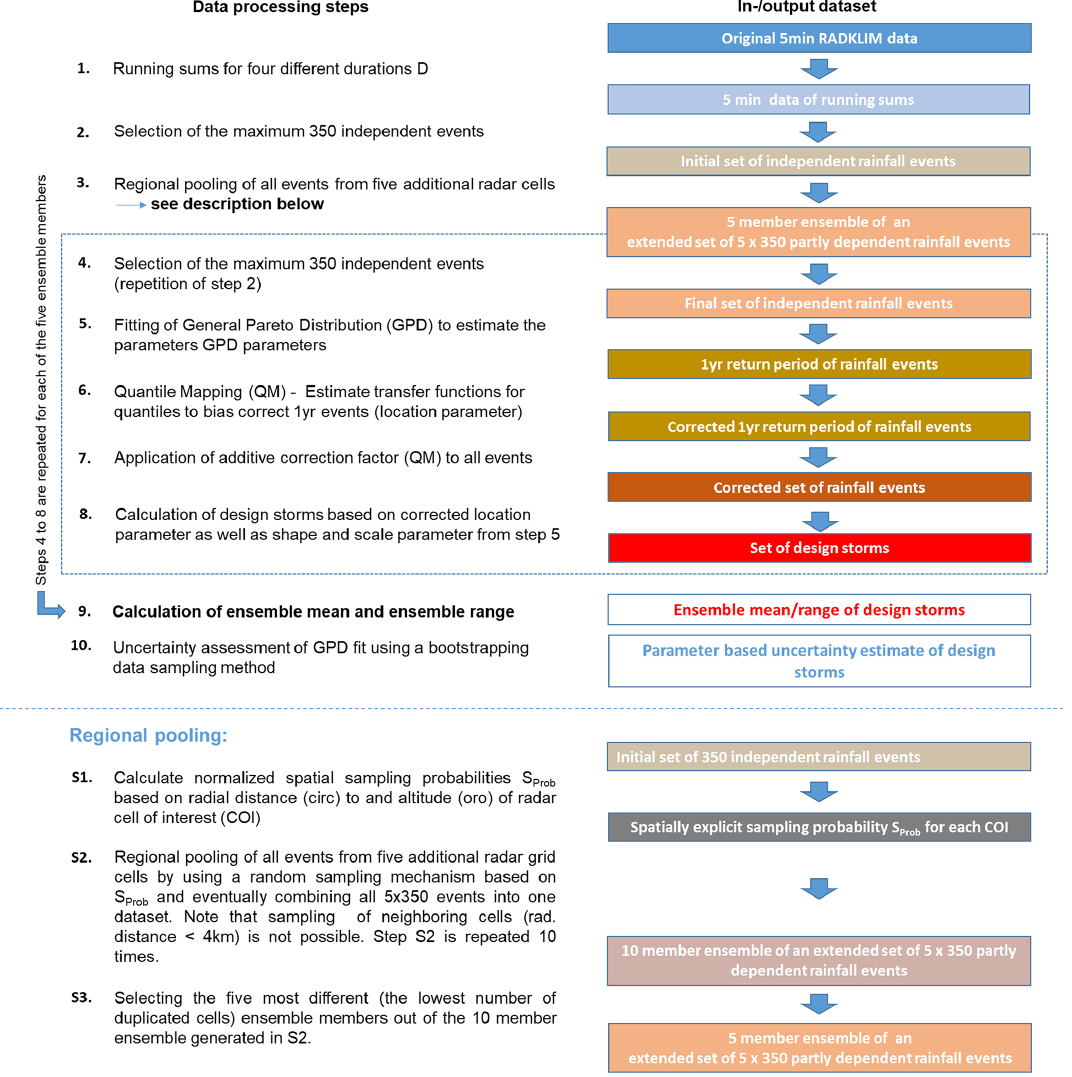
Figure 2. Flow chart visualizing the data processing chain to establish the RAD-BC dataset. The boxes describe the respective input/output dataset of each data processing steps. Note that the full data processing chain was repeated for each of the four event durations ( D = 15, 60, 360 and 1440min) considered in this